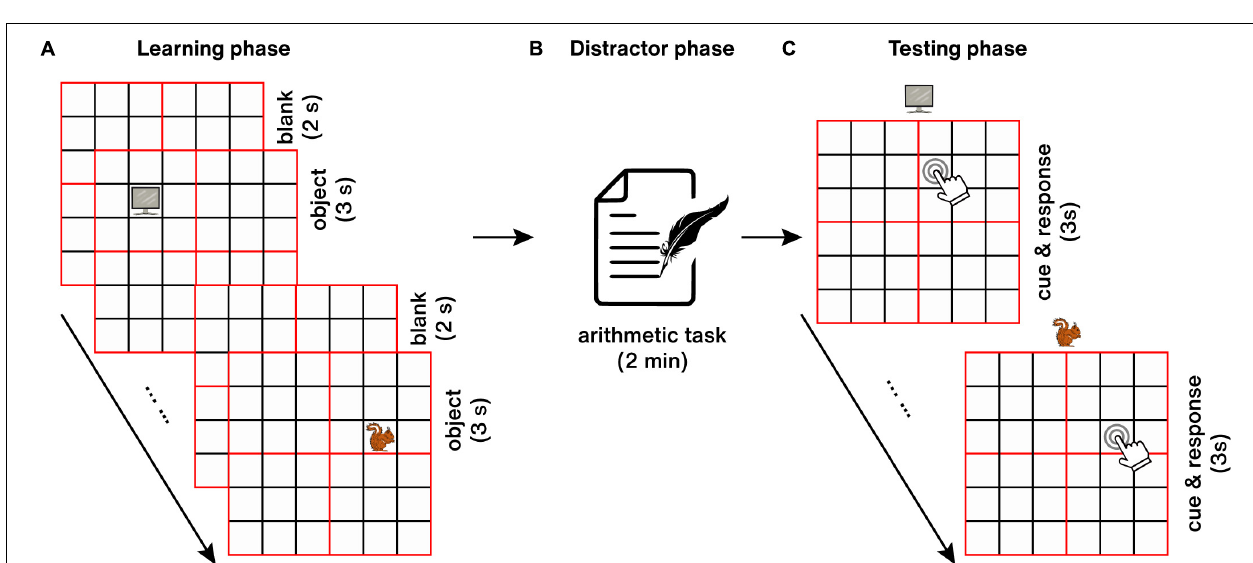
FIGURE 3 | Example of the processed HbO signal and feedback index in a complete regulation run.